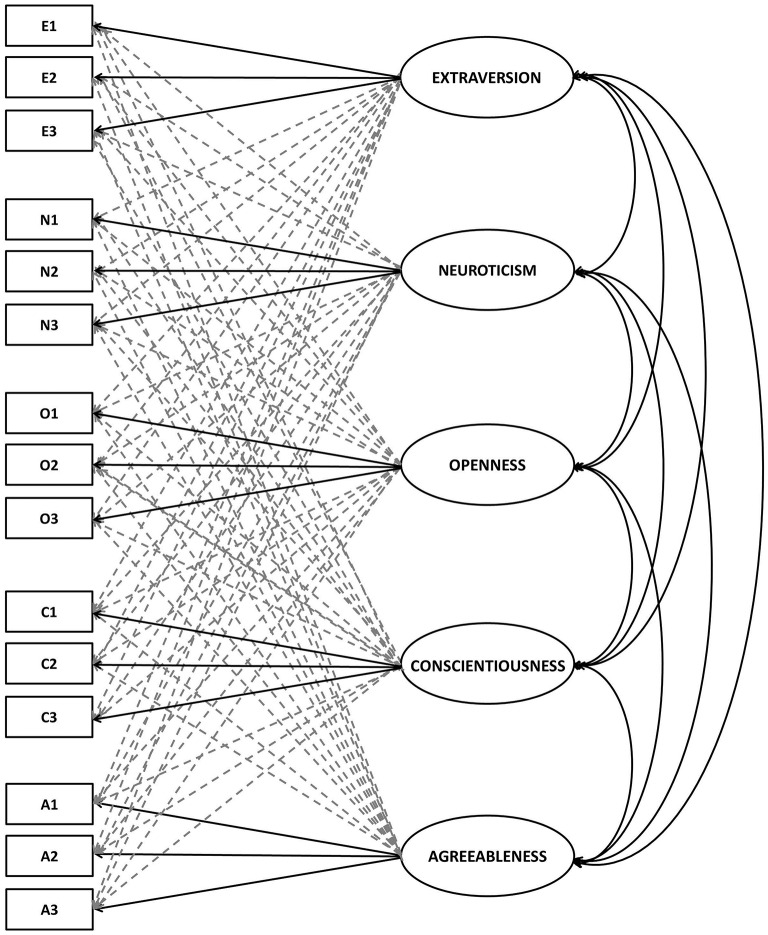
Graphical representation of tested ESEM model. Bolded lines represent expected factor loadings. Punctuated lines represent non-expected cross-loadings.